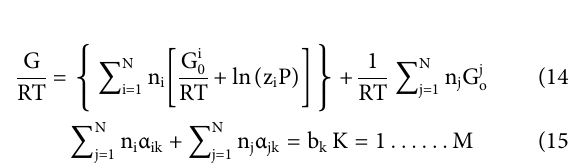
Frontiers in Energy Research |